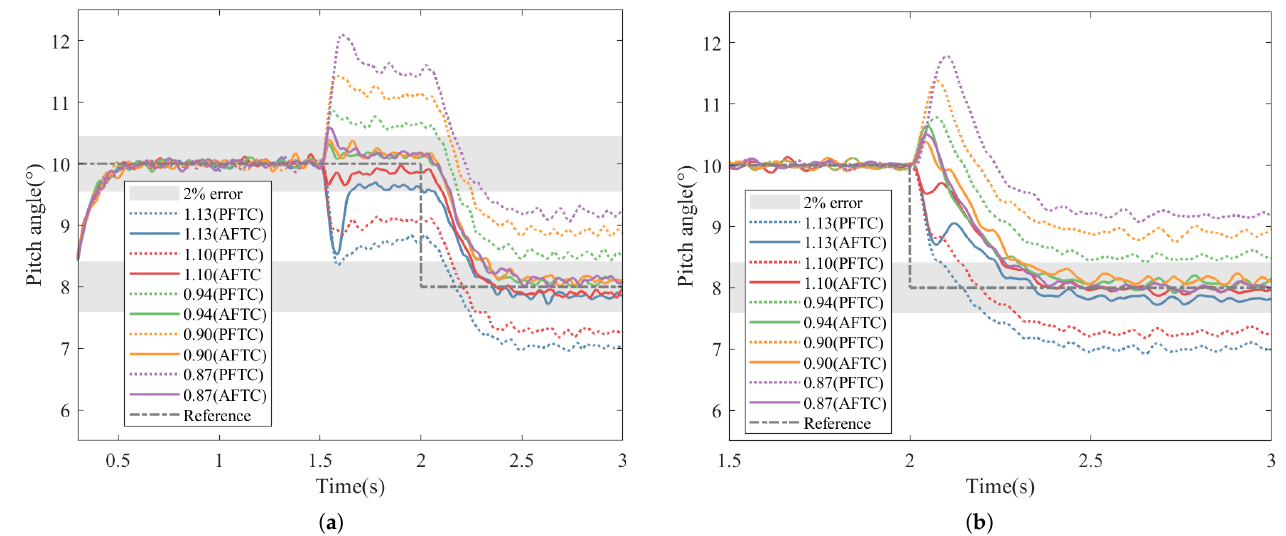
Figure 11. Comparative results of the proposed ADRC-based active fault-tolerant control for QUAV with the slow-varying fault occurred at ( a ) 1.5 s. ( b ) 2